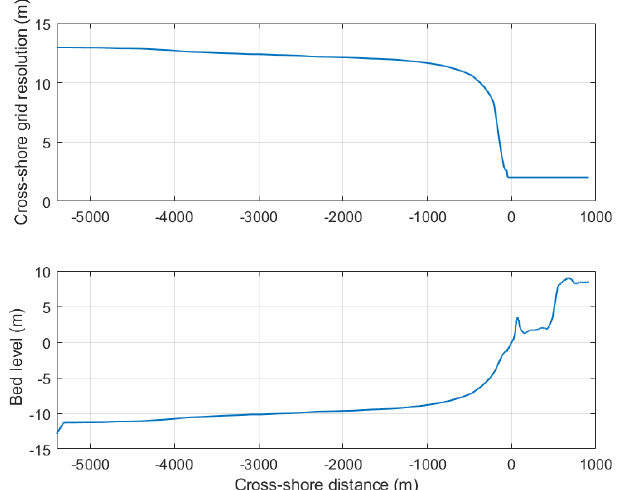
Figure 23. Varying cross-shore grid resolution based on the bed level in the extended XBeach domain. In the original non-extended domain, the cross-shore resolution is 2m, and thus a maximum res- olution of 2m is used in the extended domain. For illustration pur- poses, we show the cross-shore cross-section on the left-hand side edge of the domain.